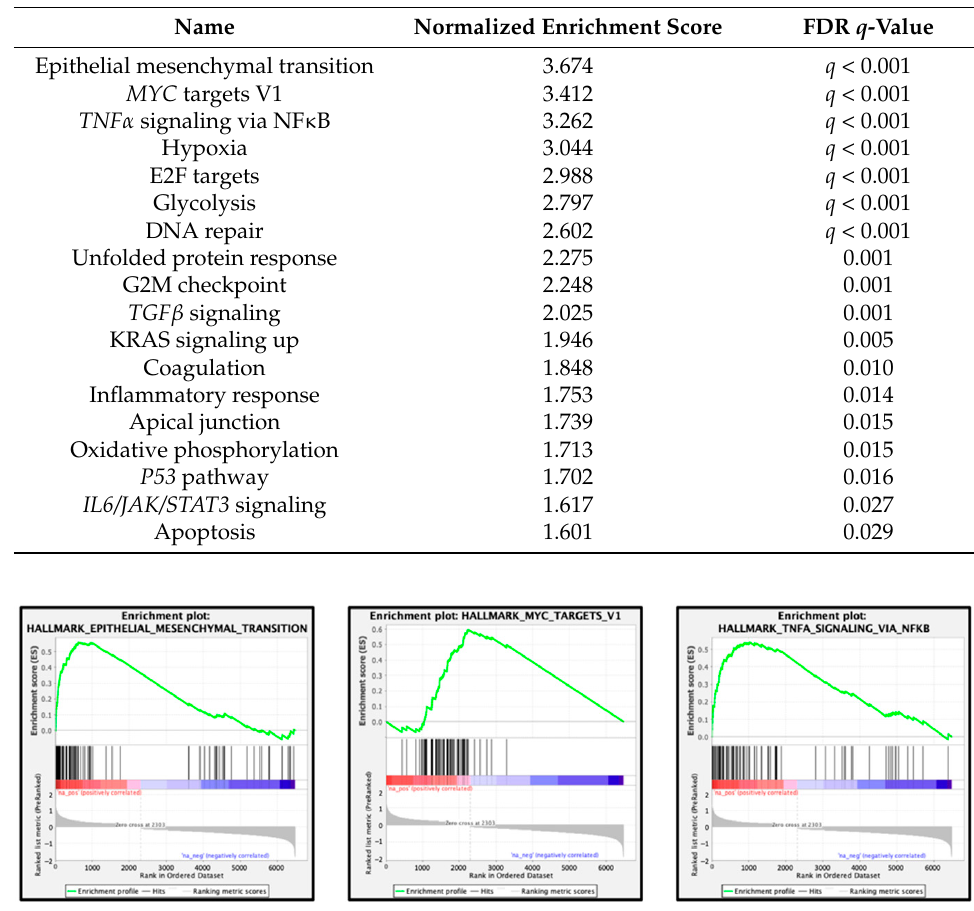
Figure 13. Pathways enriched among the differentially expressed genes in the high FOXD1 expression group according to gene set enrichment analysis. The nine significantly enriched pathways (top 9) are shown. Most enriched pathway was “Epithelial Mesenchymal Transition”. 4. Discussion In the human genome, numerous miRNAs have very similar sequences and therefore constitute a “family”. Because the seed sequences of the miRNA family are the same, each miRNA family controls the expression of the same set of genes. Therefore, aberrant expression of the miRNA family members will cause the disruption of intracellular molecular networks, and these events can initiate the transformation of normal cells to cancer cells. Based on our miRNA signatures, we previously focused on several miRNA families and identified the molecular pathways that were controlled by the miR-29 family, the miR-199 family and the miR-216 family [14,23,30].